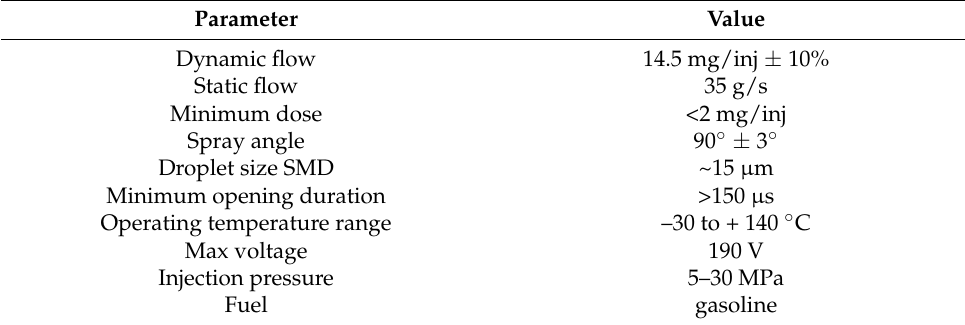
Table 3. Technical data for the Siemens VDO piezoelectric injector [35].